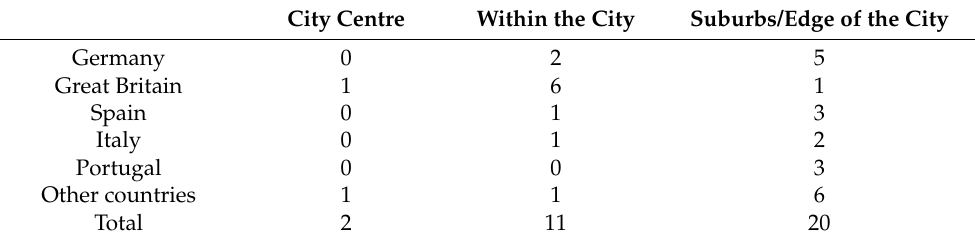
Table 2. The spatial location of stadiums constructed between 1990 and 2010 in a new location with a seating capacity of at least 30,000 (the table does not include facilities constructed on the sites of demolished old